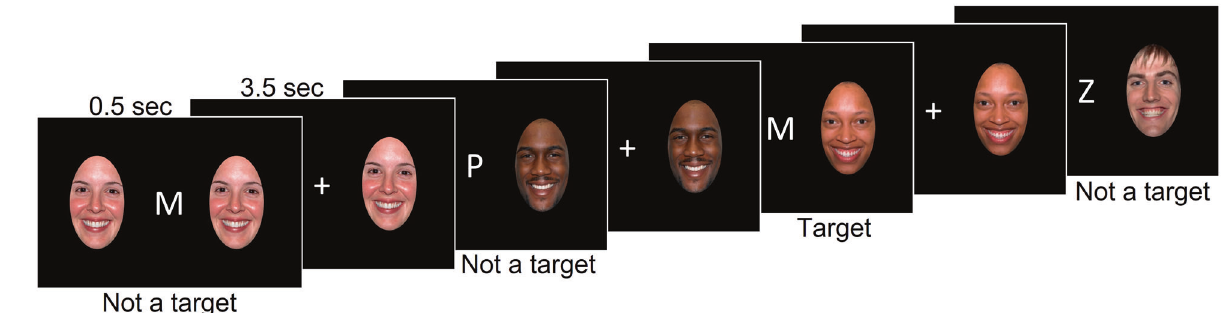
Fig. 1 Emotional faces n-back task. The fi gure illustrates the 2-back condition with happy face